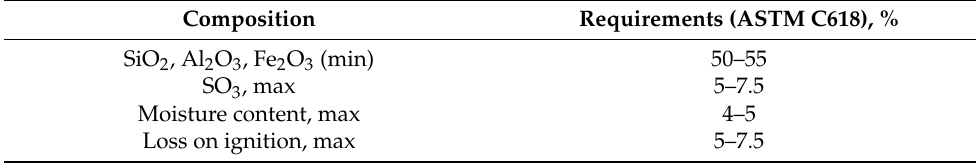
Table 3. Composition table of fly ash (C type).